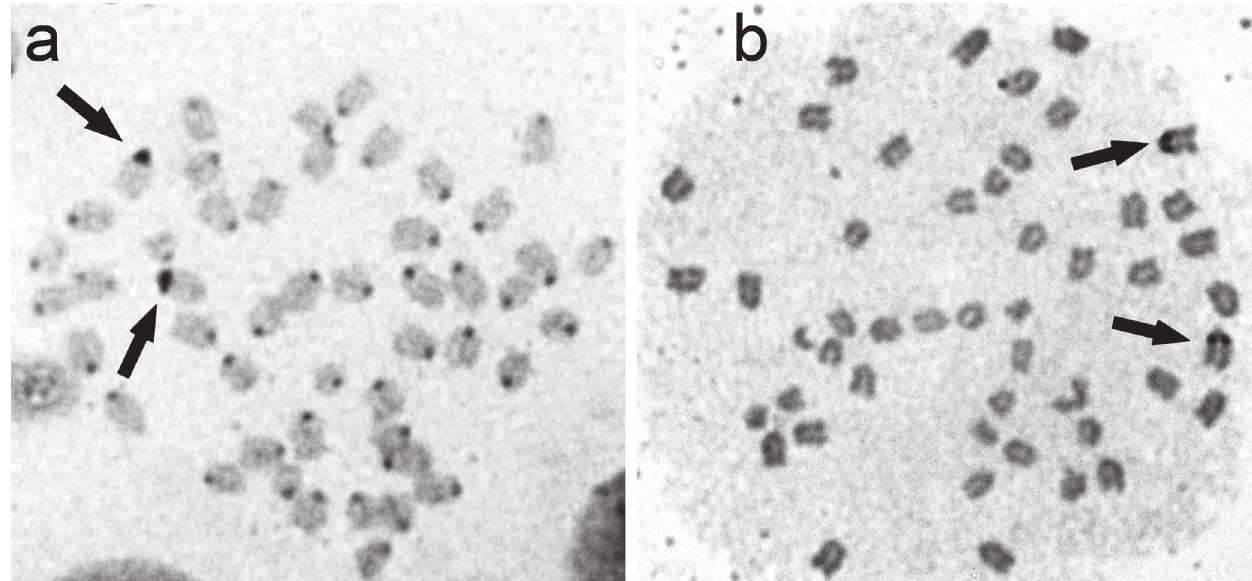
Fig. 2. Metaphase plates of Mugil incilis after ( a ) C-banding and ( b ) AgNO